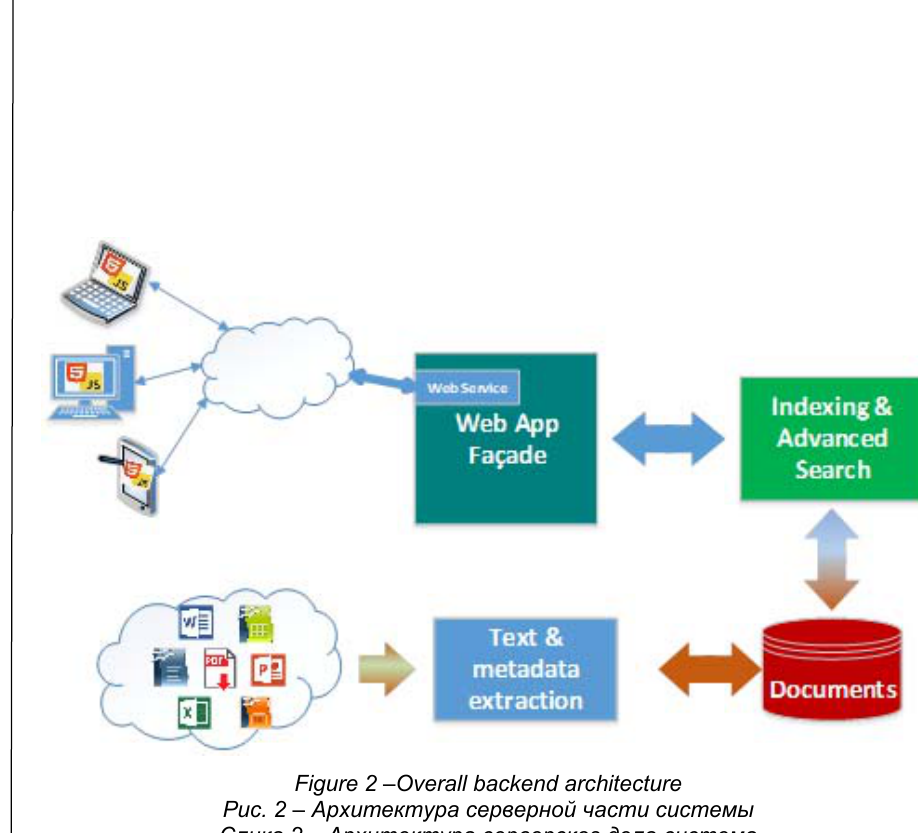
Figure 2 –Overall backend architecture Рис . 2 – Архитектура серверной части системы Слика 2 – Архитектура серверског дела